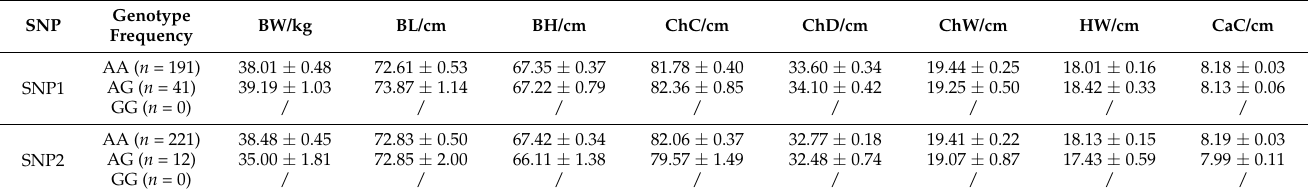
Table 5. Association analyses of SNPs and genotypes in SSTR1 with growth traits of Hulun Buir sheep at 16 months of age 1